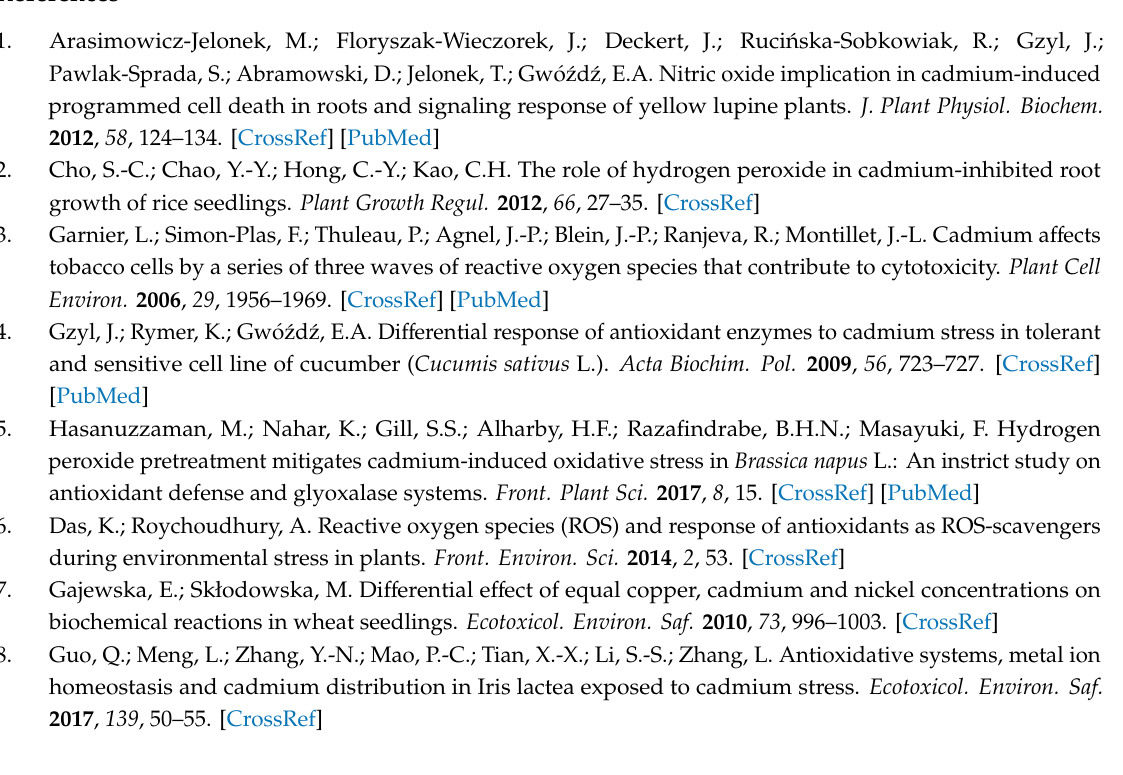
Table S1: Percentage of Cd content in particular organs of recovered plants. TF—root-to-shoot translocation factor. Statistically significant di ff erences in Cd accumulation in specific organs by p = 0.05 are marked with di ff erent letters, Table S2: Content of non-essential elements in the roots, stems, and leaves of soybean plants after the recovery period from Cd stress. Values are means of 2–3 repetitions ± SE. No significant di ff erences between Cd-treated and control plants were